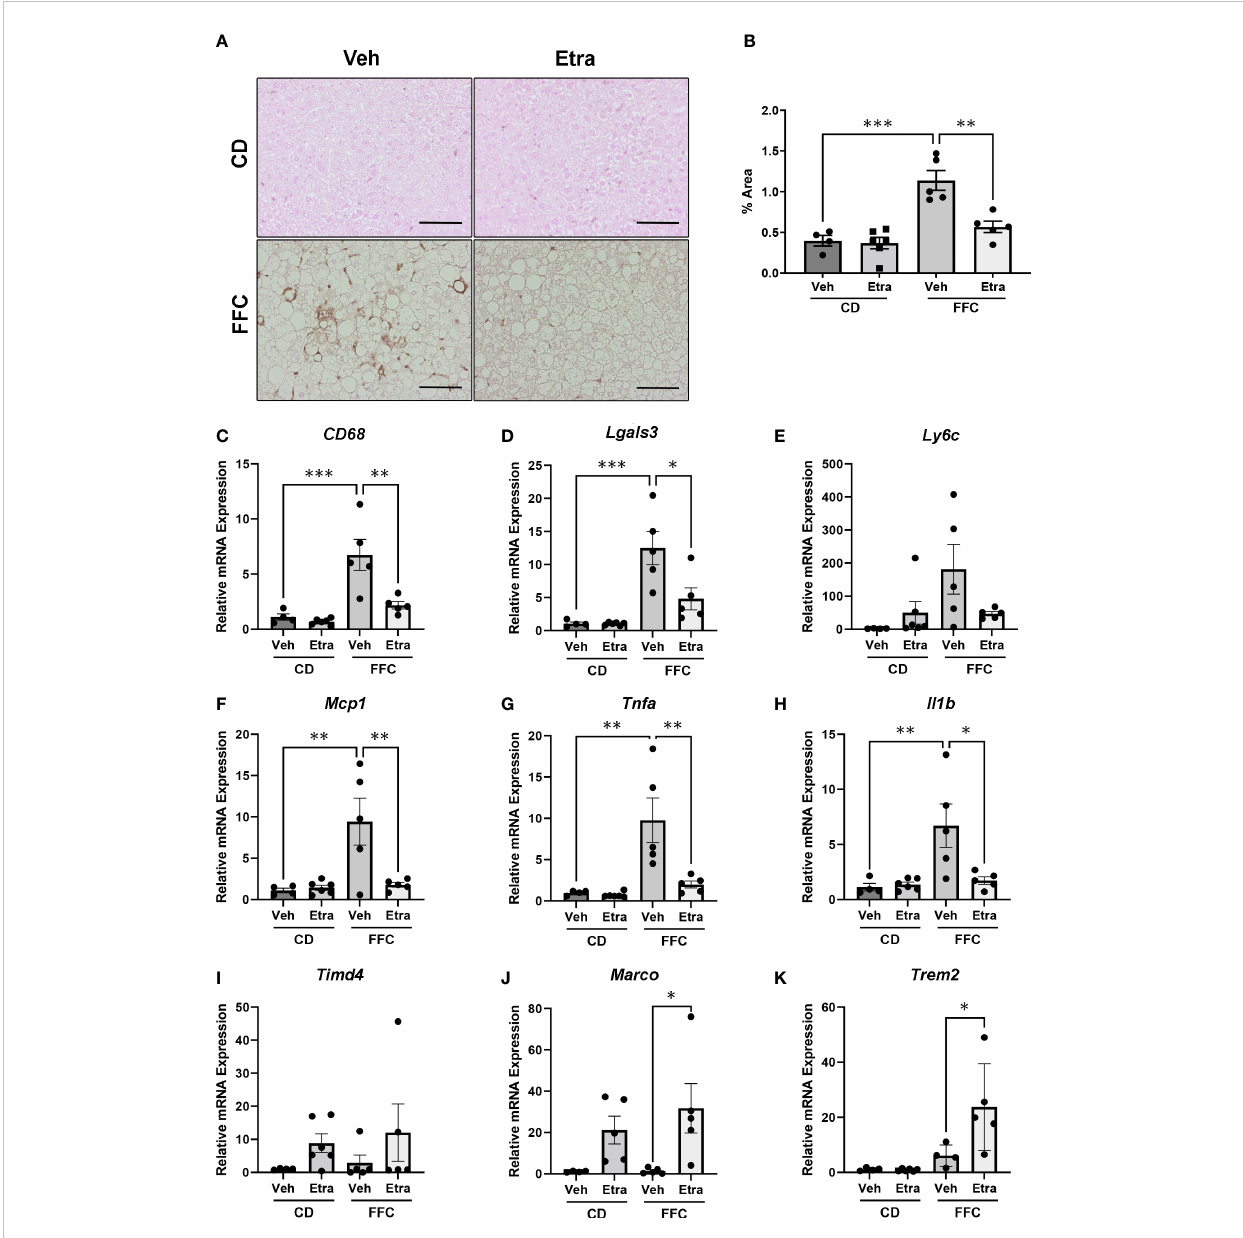
FIGURE 5 Macrophage accumulation and in fl ammatory markers are reduced in Etrasimod treated mice. (A) Representative images showing immunohistochemistry for Mac-2 in liver tissue sections for vehicle and Etrasimod treated mice in both CD and FFC cohorts. Scale bar equals